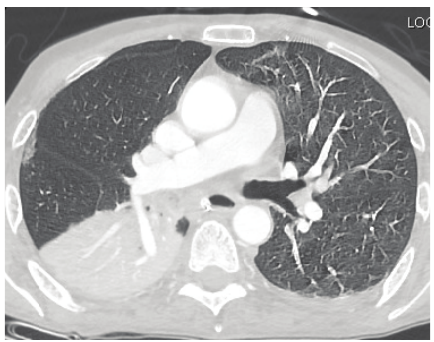
Figure 4: CT scan of the chest showing aspiration pneumonitis.